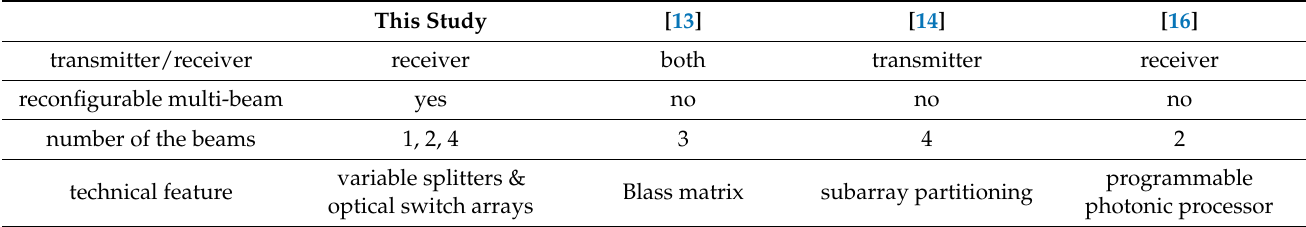
Table 1. The comparison to related